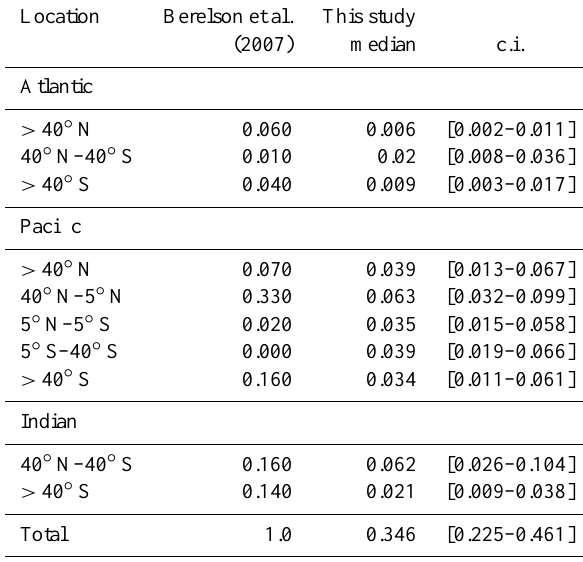
Table 5. Dissolution rates of biogenic CaCO 3 [Gt Cyr − 1 ] in the upper water column (200–1500m depth levels) based on the TA ∗ CFC age method as summarised in Berelson et al. (2007), and as constrained by TA ∗ data in our Latin hypercube ensemble (includ- ing the sediment correction, median and 68% c.i.). The dissolution estimates by Berelson et al. (2007) were assigned an estimated un- certainty of ∼